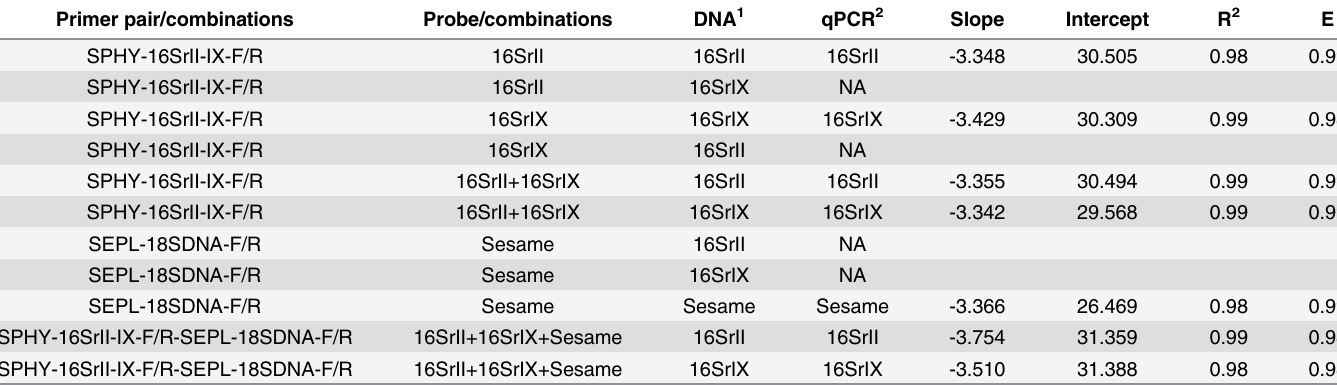
Table 3. Slope, intercept, correlation coefficients (R 2 ), and efficiencies (E) of qPCR assay. Primer